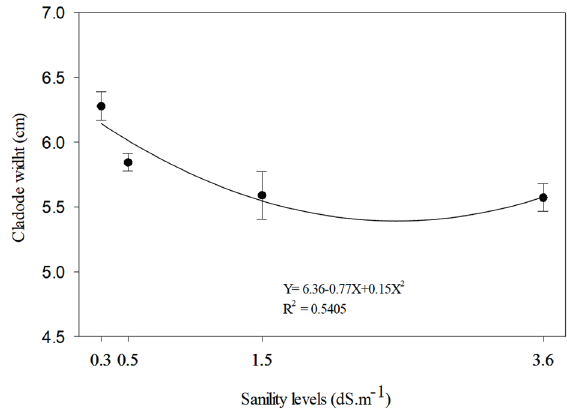
Figure 2 - Cladode width of cactus pear cv. Miúda according to the salinity levels of water irrigation. Error bars represent the standard error of the